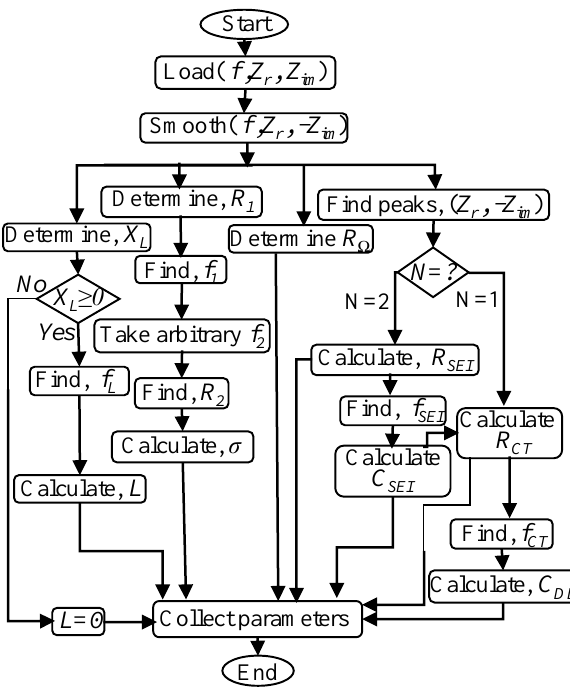
Figure 8. Parameter extraction algorithm